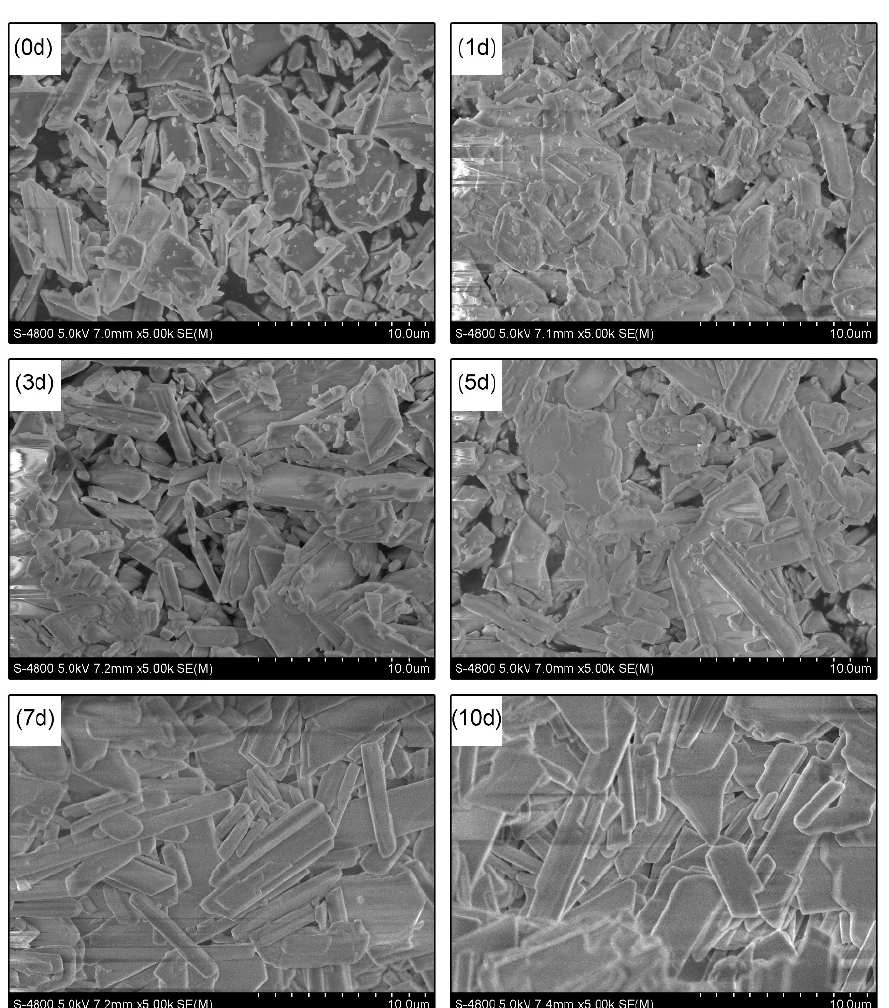
Figure6. SEMmicrographsofCScementsafter0, 1, 3, 5, 7, Figure 6. SEM micrographs of CS cements after 0, 1, 3, 5, 7, and 10 days immersed in Tris–SBF-27 solution.